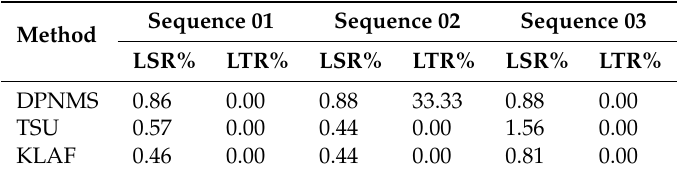
Table 3. Tracking performance for our